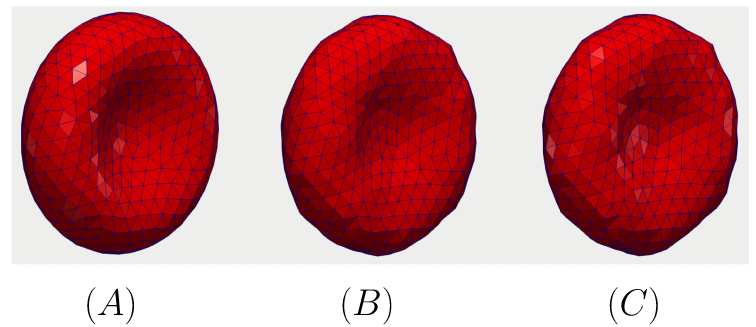
Figure 7. The relaxation of the RBC under zero-shear condition. The initial shape of the RBC is the analytical shape as discussed in Section 2.2 at t = 0 ( A ). The RBC relaxes toward the stress-free condition in ( B ) ( t = 200 µ s) and ( C ) ( t = 400 µ s). The results are taken from the Grid-1 simulation as indicated in Table 2.